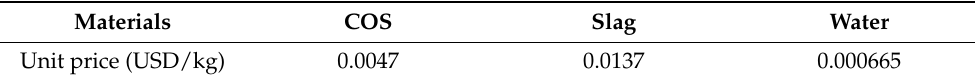
Figure 3. Preparation process for the samples. Table 3. Material Cost